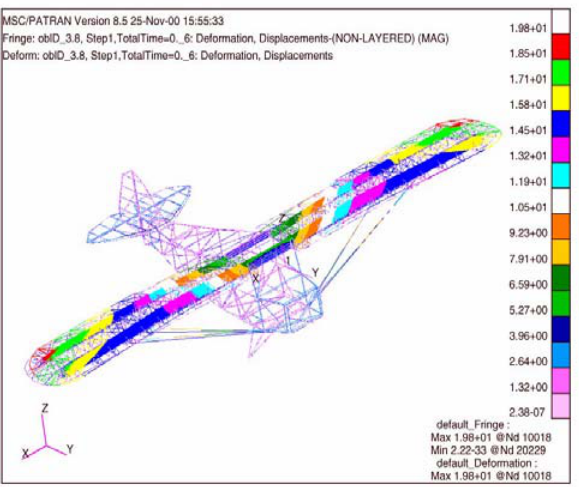
Fig 4. Displacement magnitudes caused by overload in point D